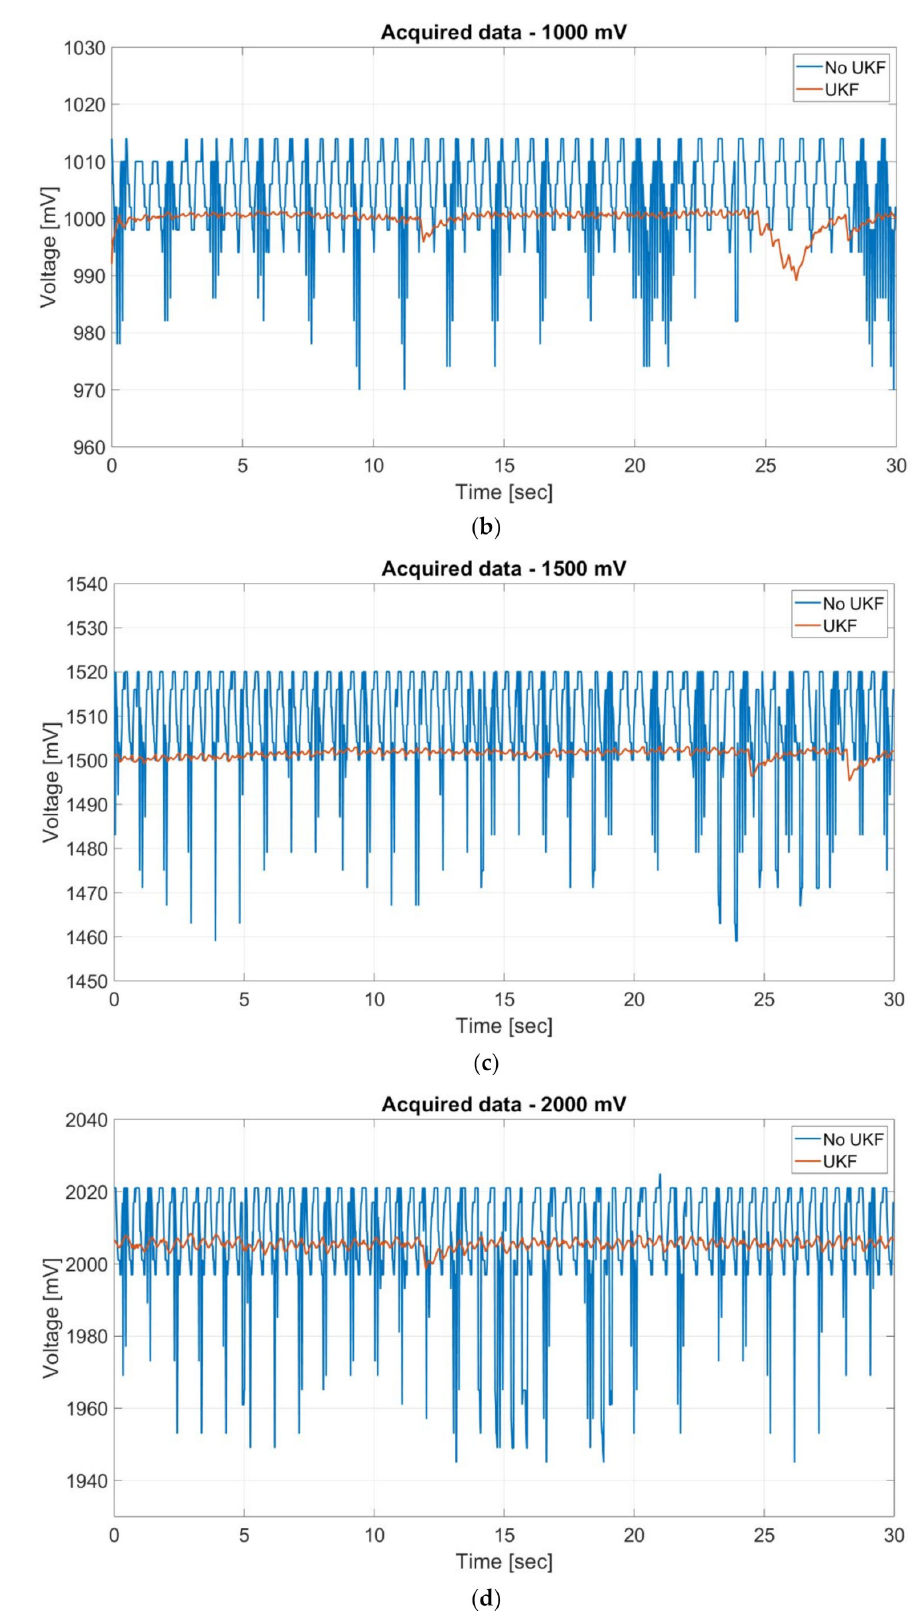
Figure 13. Graphical results of the experiment for data acquisition and elaboration: ( a ) acquired data at voltages of about 500 mV; ( b ) acquired data at voltages of about 1000 mV; ( c ) acquired data at voltages of about 1500 mV; ( d ) acquired data at voltages of about 2000